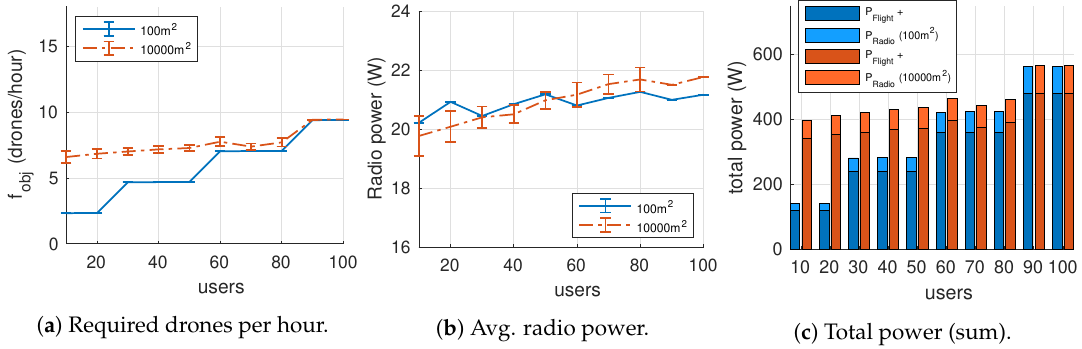
Figure 7. Results for the individual VoIP channels